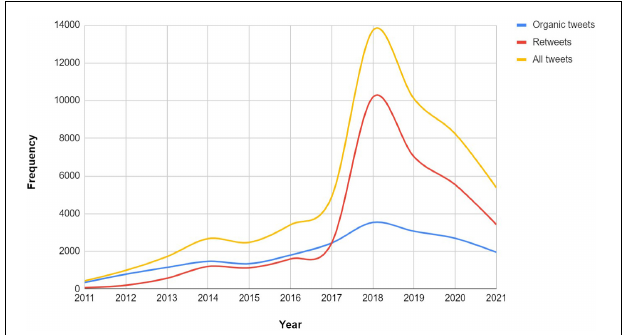
FIGURE 1 | Breakdown of all the retrieved tweets (yellow line), original tweets (blue line) and retweets (red line) of SRL (2011–2021). Best viewed in